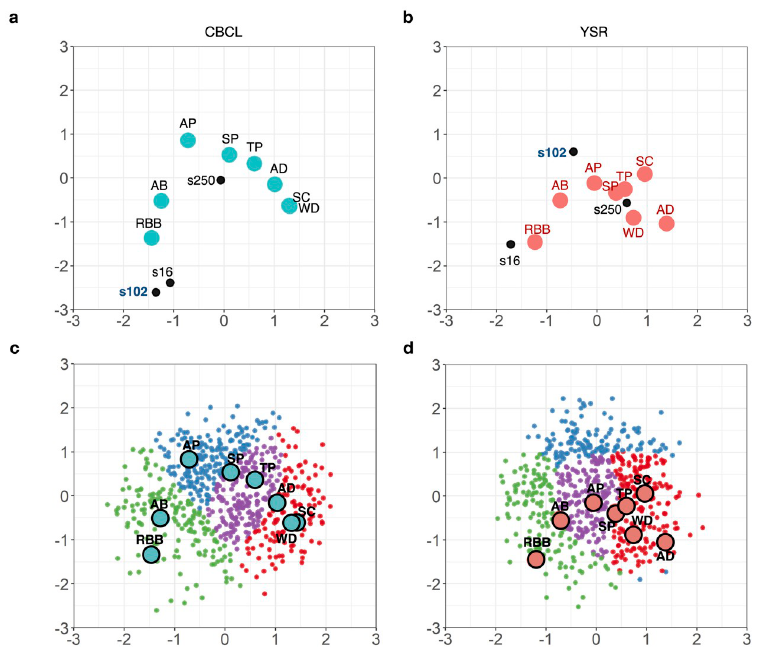
variables for respondents are plotted in a latent coordinate. Latent positions for syndromes are presented as colored circles with solid black borders, and respondents’ latent positions are displayed as dots. Three respondents are exemplary selected based on their latent positions in the CBCL and YSR: the two respondents located in the center (s250) and in the boundary (s16) show similarity between children and parents but s102 show difference in the latent positions between children and parents. (c) and (d) show the K-means clustering results of all respondents based on the distance from all item syndromes in the CBCL and YSR